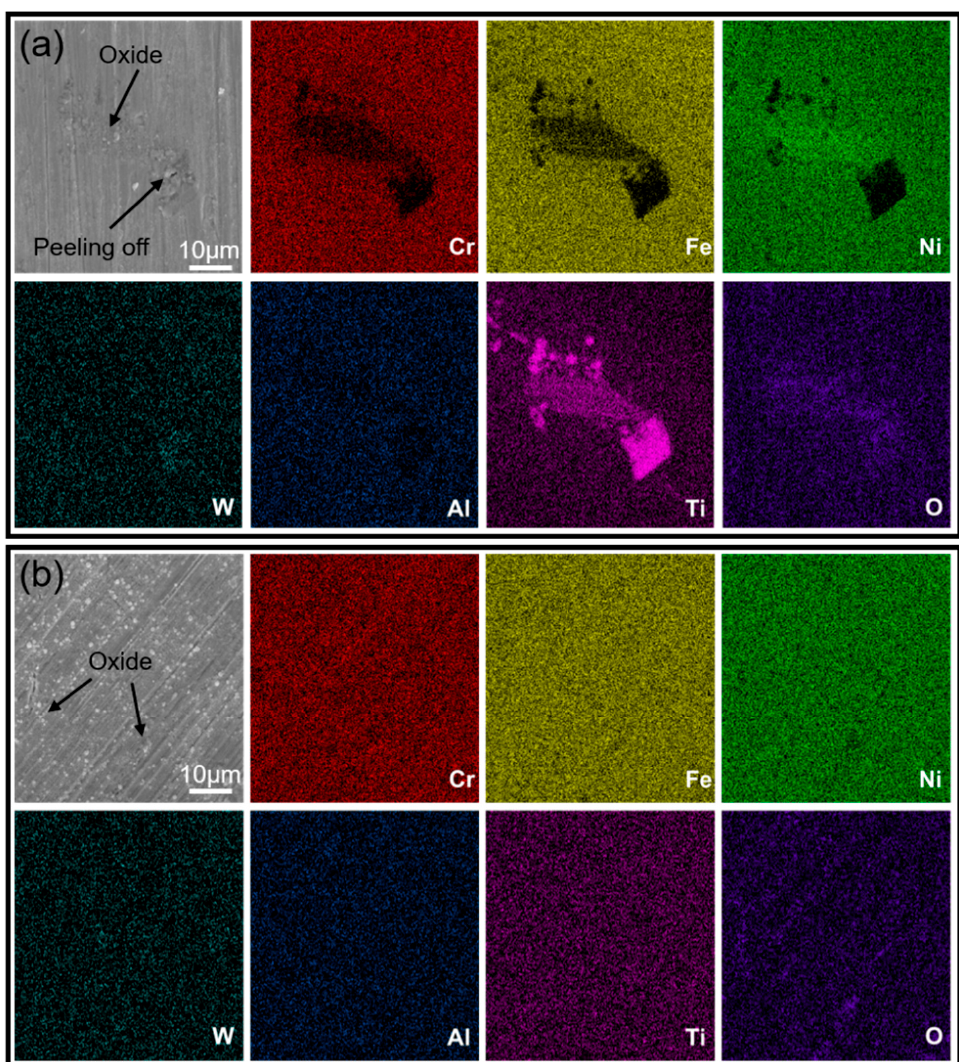
Figure 8. SEM images and mapping after oxidation at high temperature for 30 h. ( a ) As-cast, ( b )